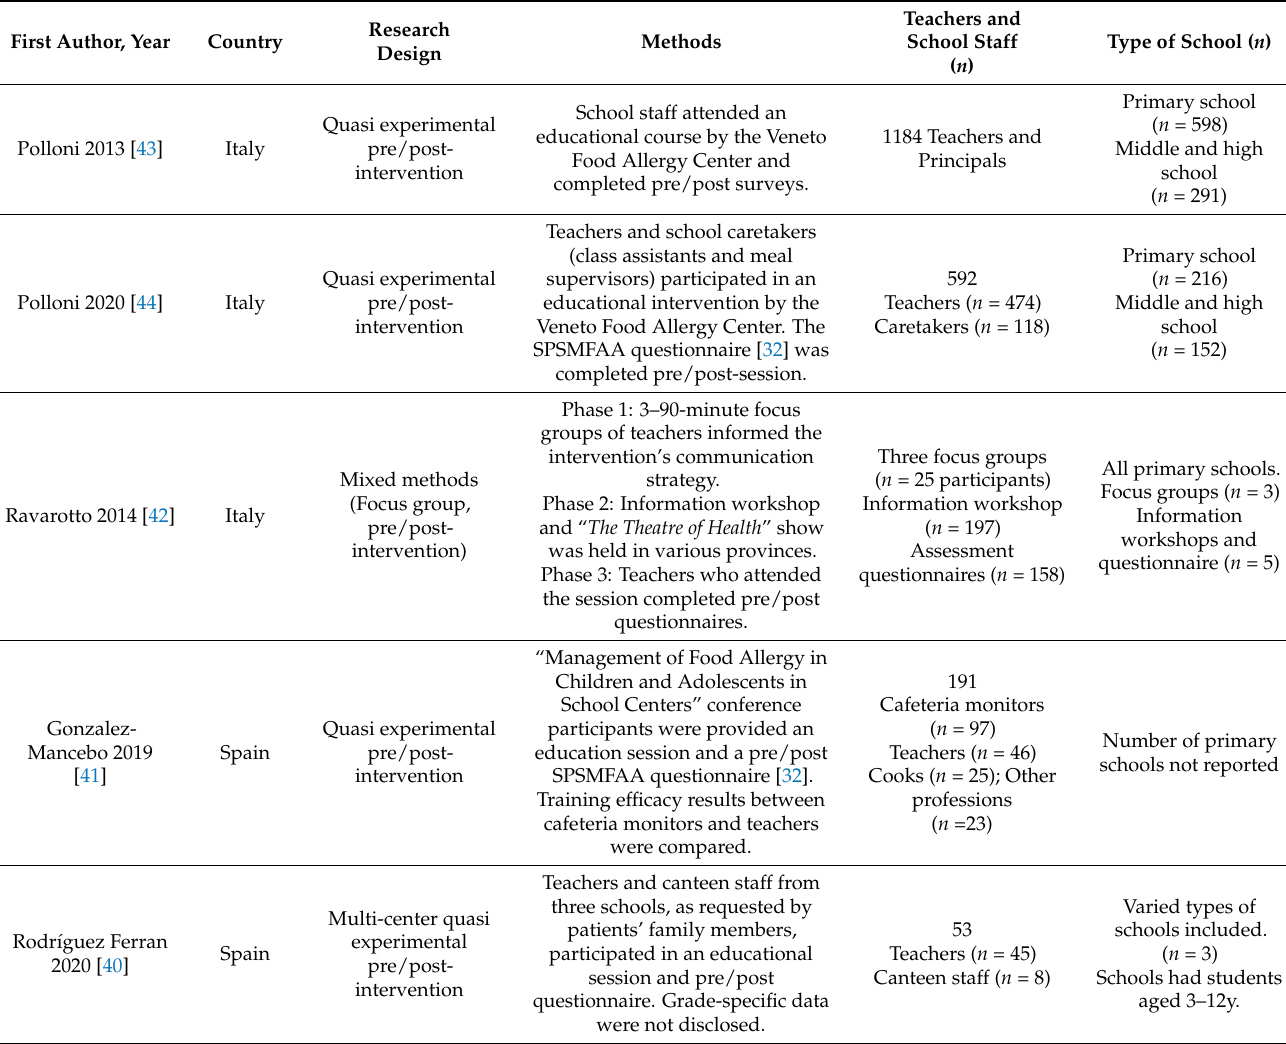
Table 1. Summary of articles’ country of origin, research design, methods, and population, presented in alphabetical order by first author’s last